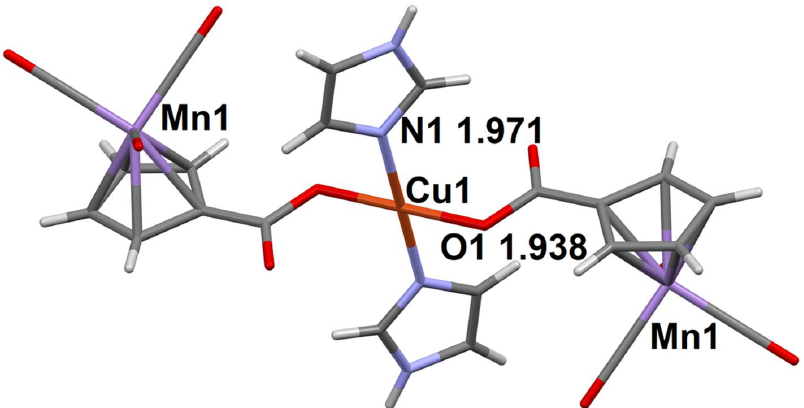
Figure 5 . The structure of complex molecule in 7 . The distances between the coordinating atoms of the ligands and the Cu 2+ ion are given (Å). the ligands and the Cu 2+ ion are given